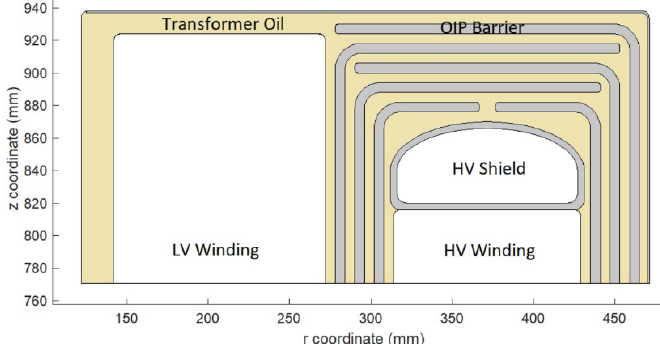
Figure 6. The dielectric structure of the real scale MFT.